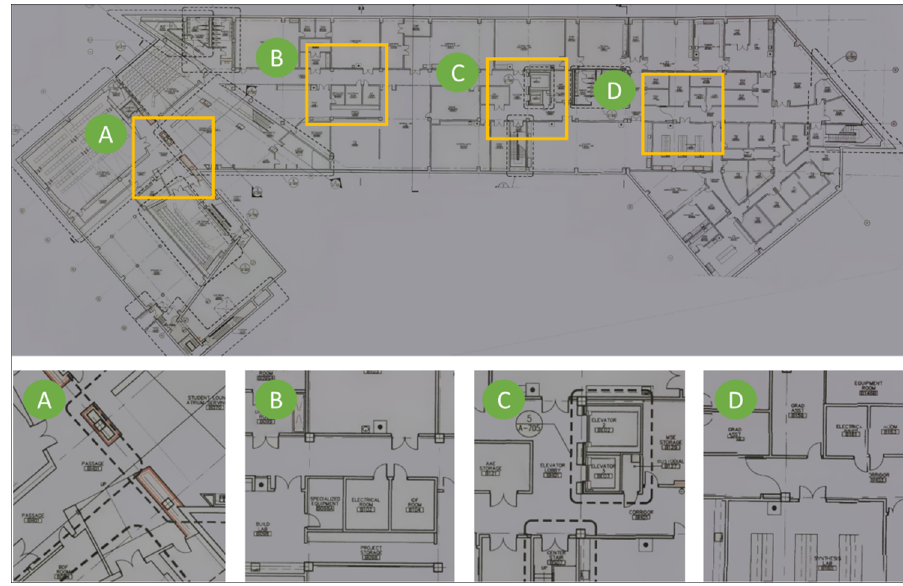
Figure 7. Drawing image reconstructed using DrawImgs: The four images on the bottom are magnified areas corresponding to the boxes on the drawing on the left.